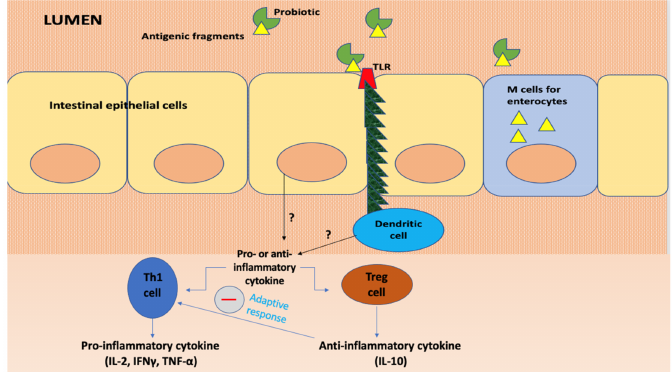
Figure 1. The immunomodulatory properties of